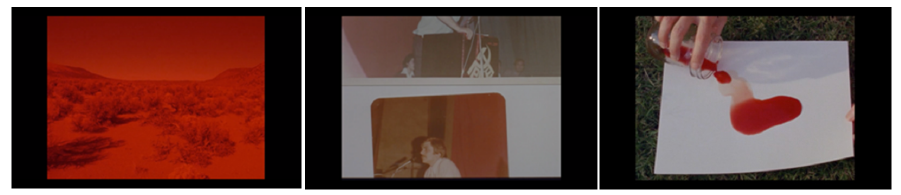
Figure 2. 025 Sunset Red